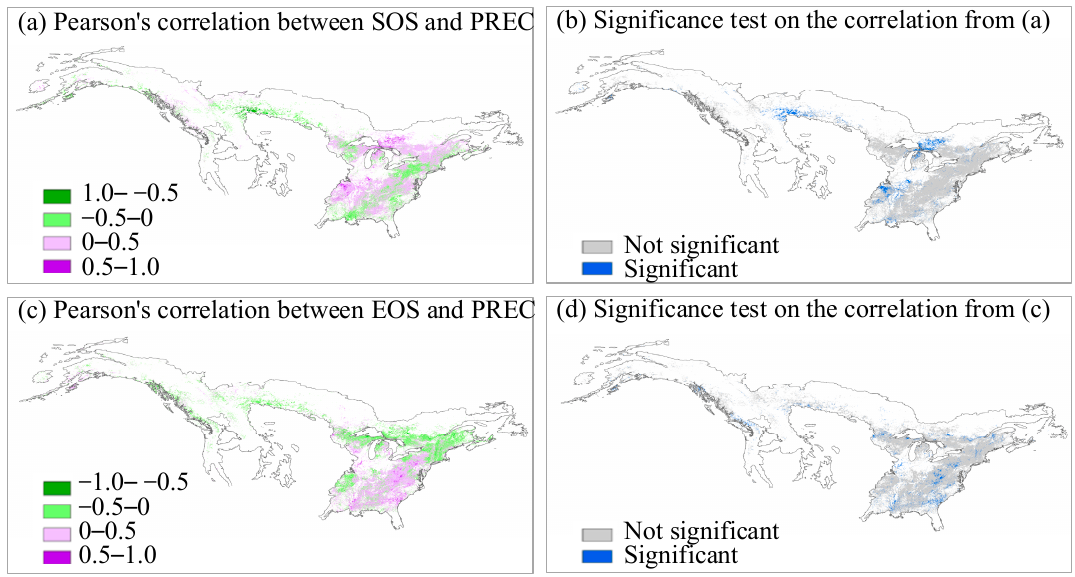
Figure 6. The impact of the annual total precipitation (PREC) on the phenological events in the deciduous forests.